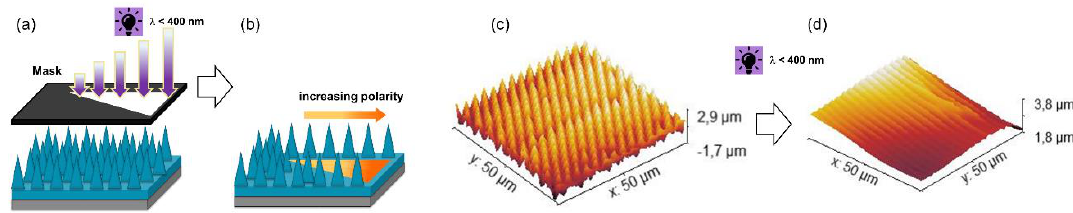
Figure 12. Schematic illustration of ( a,b ) Patterned and asymmetrical UV exposure on NIL thiol-acrylate structure. ( c ) SEM micrographs of the topography of needle-like micropatterns inscribed by visible light assisted NIL ( d ) Surface structures of the photocured photopolymer after 1500 s of UV exposure (269 mW/cm 2 ) under air (Adapted from reference [90] published by the Royal Society of Chemistry).